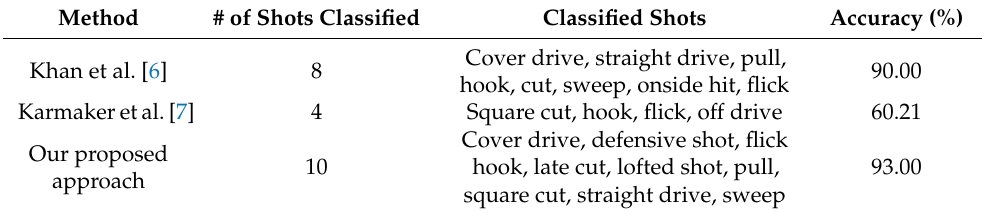
Table 12. Accuracy comparison with similar work.